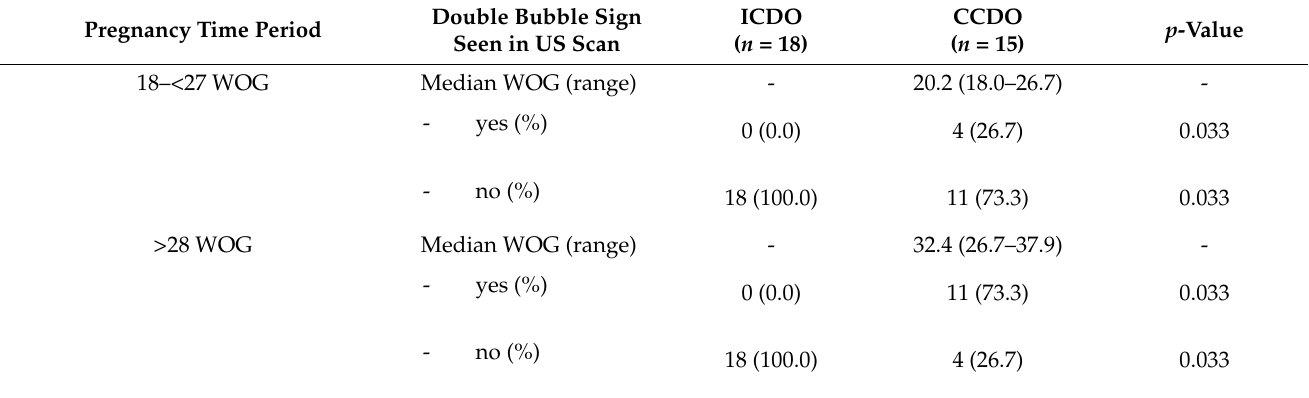
Table 4. Detection of the double bubble sign in fetuses with complete or incomplete duodenal obstruction by ultrasound scan during two different periods in pregnancy (18 to < 28 and ≥ 28 weeks of gestation).